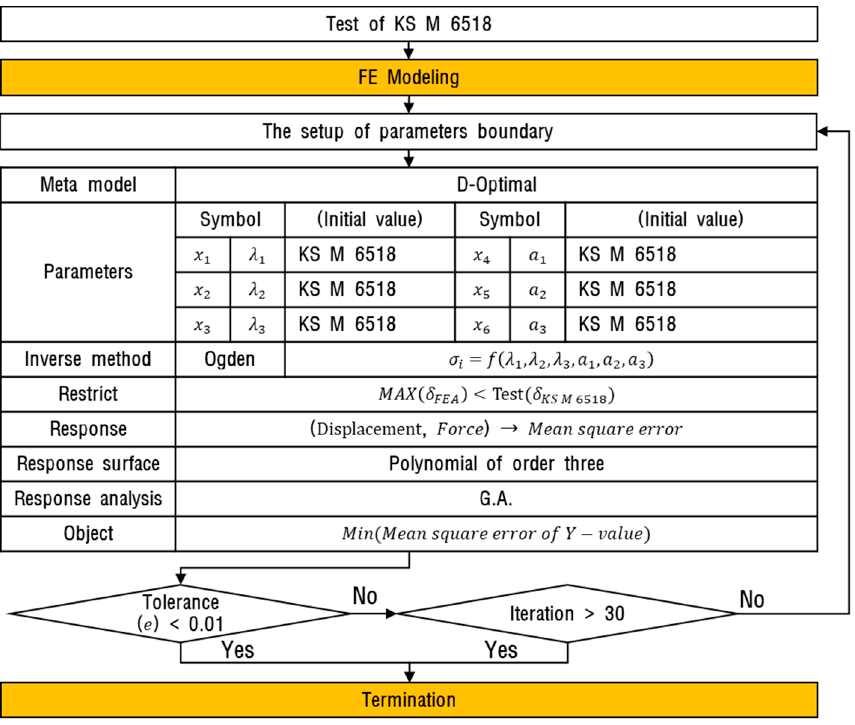
Figure 7. Fitting procedure of Ogden’s incompressible model using the inverse method.